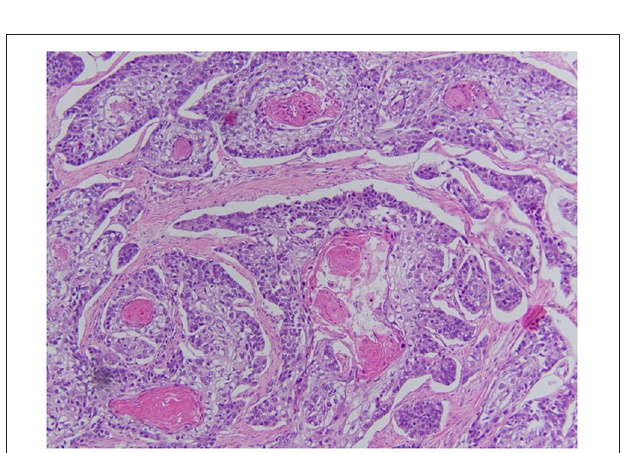
FIGURE 8 | Squamous portion of the tumor. Demonstrates keratinization and intracellular bridges. There is a variation in size of the nuclei, there is nuclear atypia and prominent nucleoli.